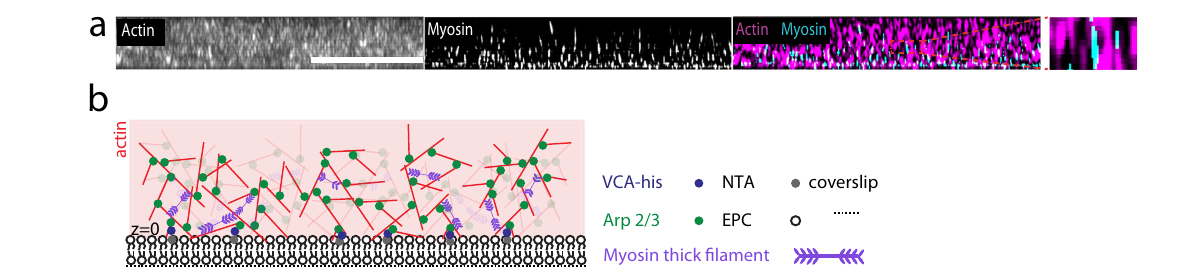
F-actin network. Scale bar is 5 μ m. The actin (red) and myosin (black) normalized intensity plots as a function of depth z are on the left of actin z stack, respectively. Three independent experiments were done with similar results. b Diagram of myosin thick fi laments within Arp 2/3-nucleated F-actin